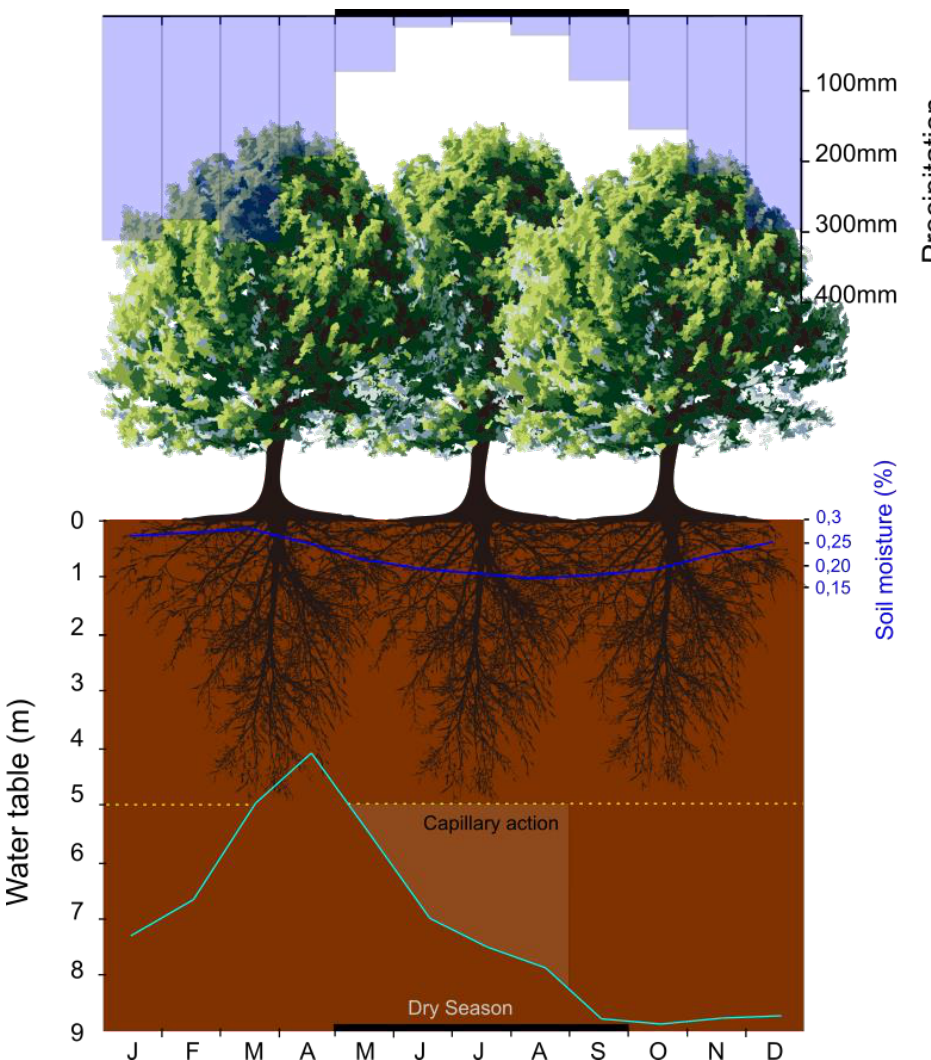
Figure 9. Scheme of plant water supply via water table (average monthly), precipitation (average monthly) and soil moisture (average monthly).